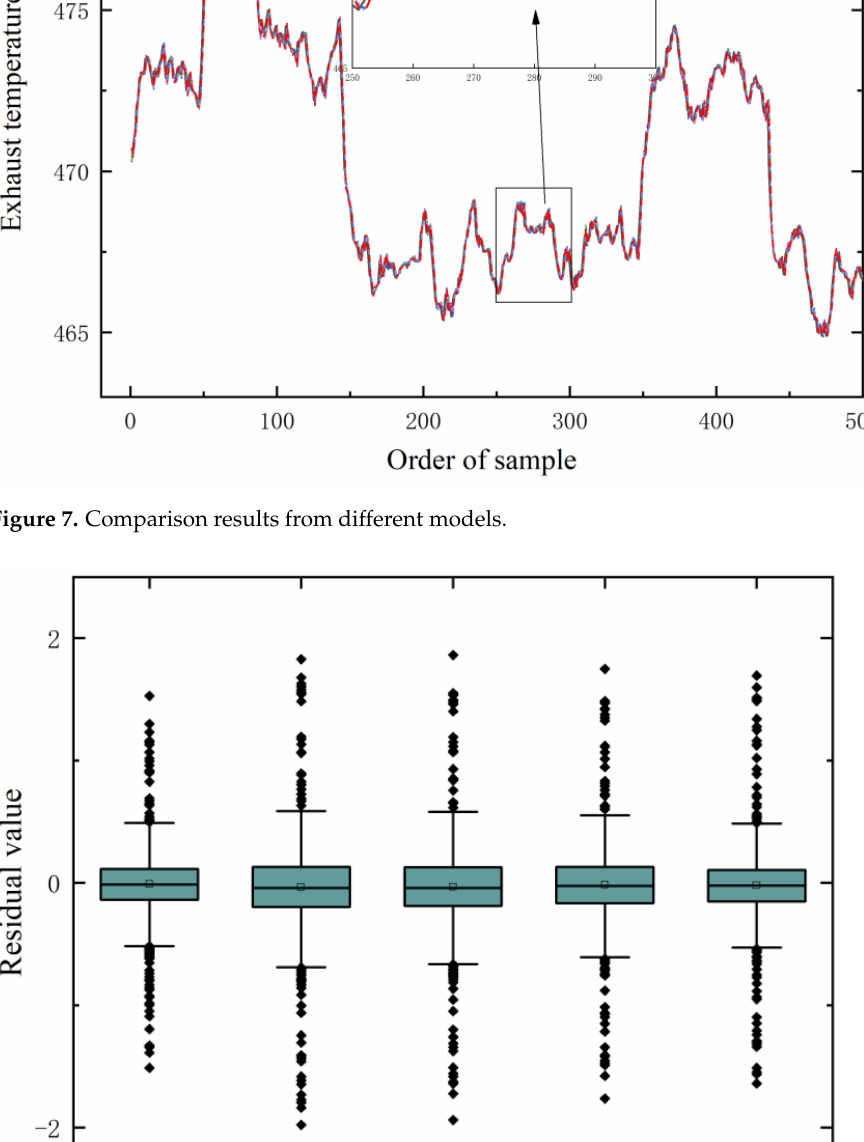
Figure 7. Comparison results from different models. Table 6. Evaluation index of prediction results of different models.